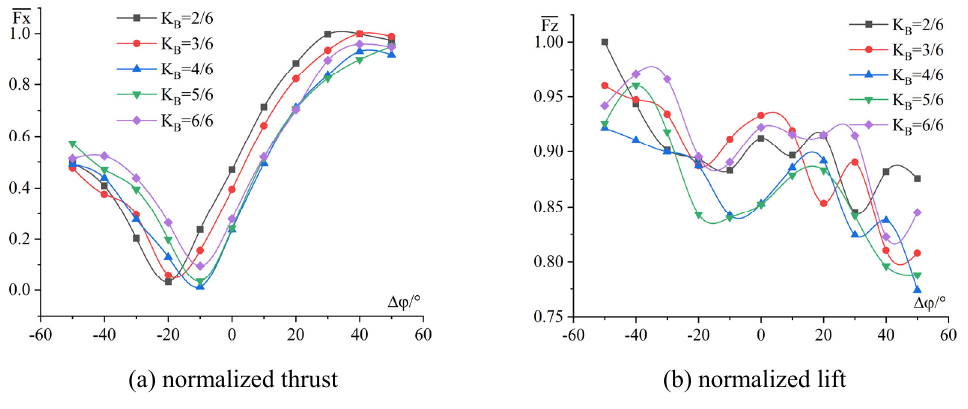
Figure 10. Effect of phase difference on rear edge.